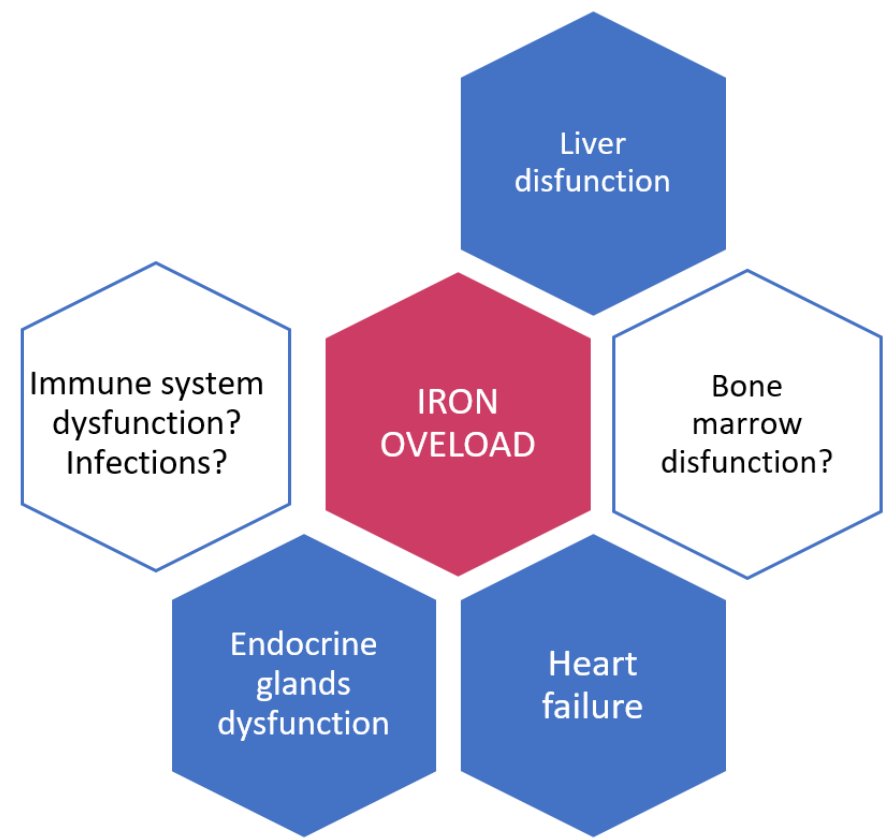
Figure 1. Effects of iron overload on target organs.